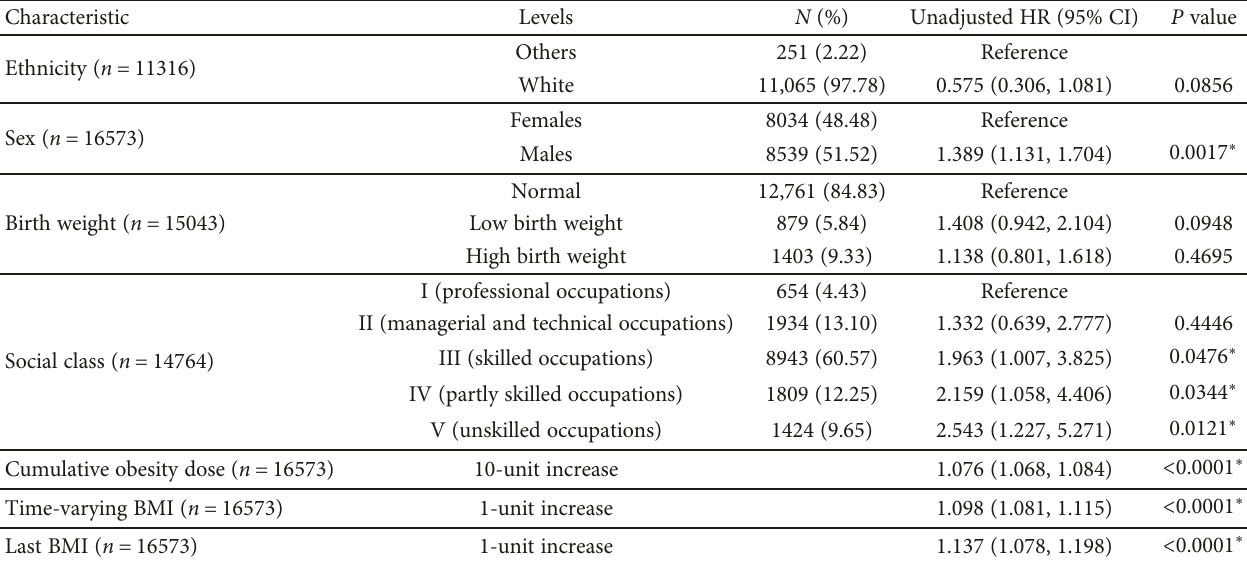
Table 2: Unadjusted hazard ratios (HRs) of developing diabetes using univariate Cox regression analyses.